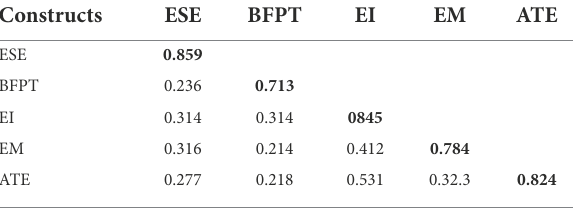
TABLE 3 Discriminant validity.